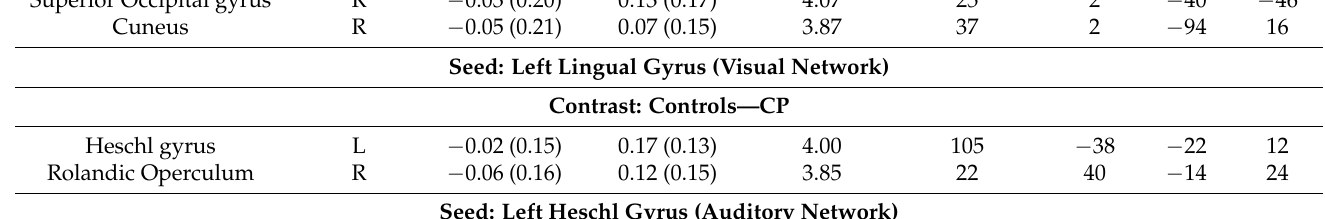
Superior Occipital gyrus